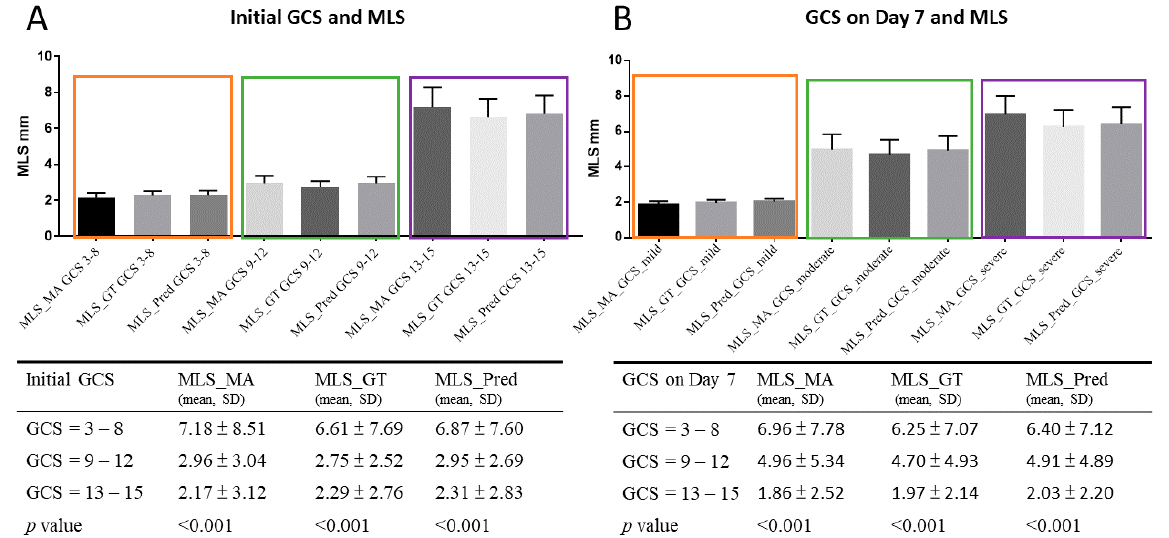
Figure 3. Figure 3 shows the midline shift measured by different methods in different patients with